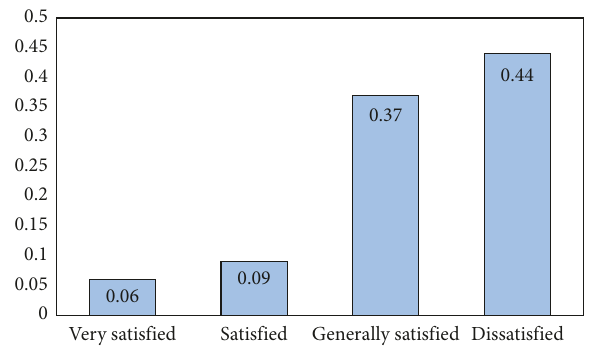
Figure 6: Educational background of auditors in an insurance company A .